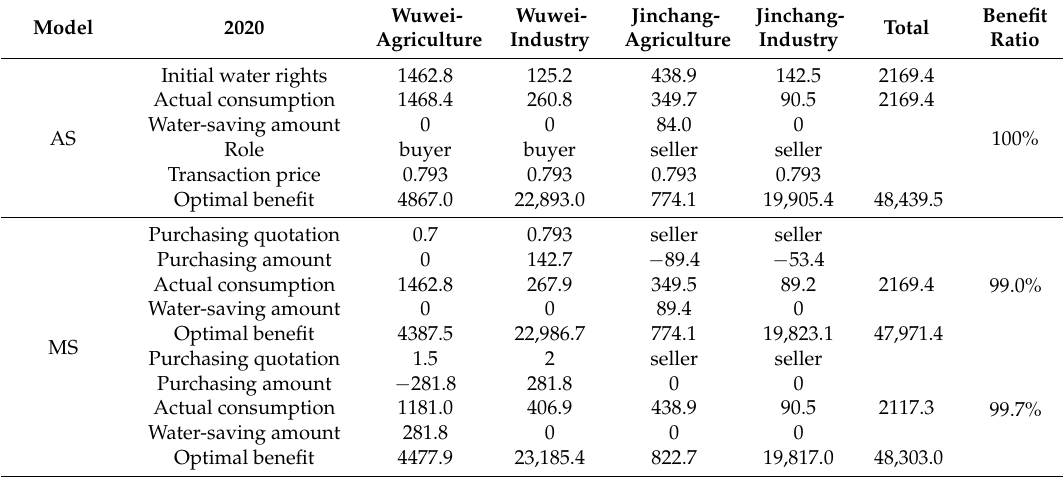
Table 14. Comparison of the results obtained from the two systems in 2020 (million m 3 , yuan/m 3 , million